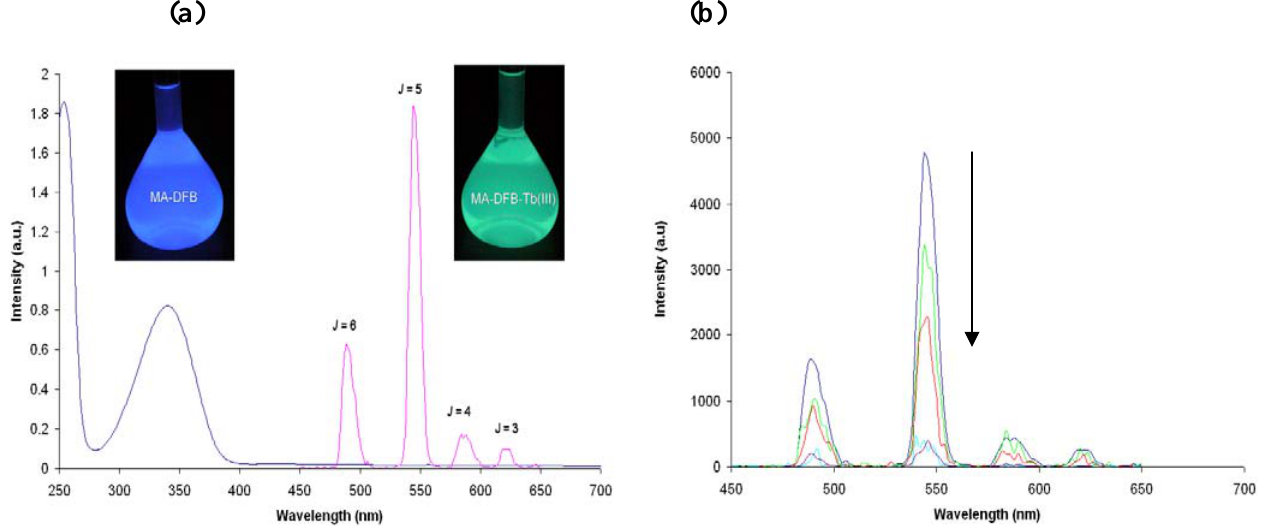
Figure 3. (a) The UV-Vis (340 nm) and the corresponding Luminescence spectrum of compound 3b (Ex = 340 nm) in ethyl acetate (1 × 10 –8 M) and (b) The UV-Vis (340 nm) and the corresponding decreasing Luminescence of compound 3b (Ex = 340 nm) in ethyl acetate (1 × 10 –8 M) with increasing amounts of FeCl 3